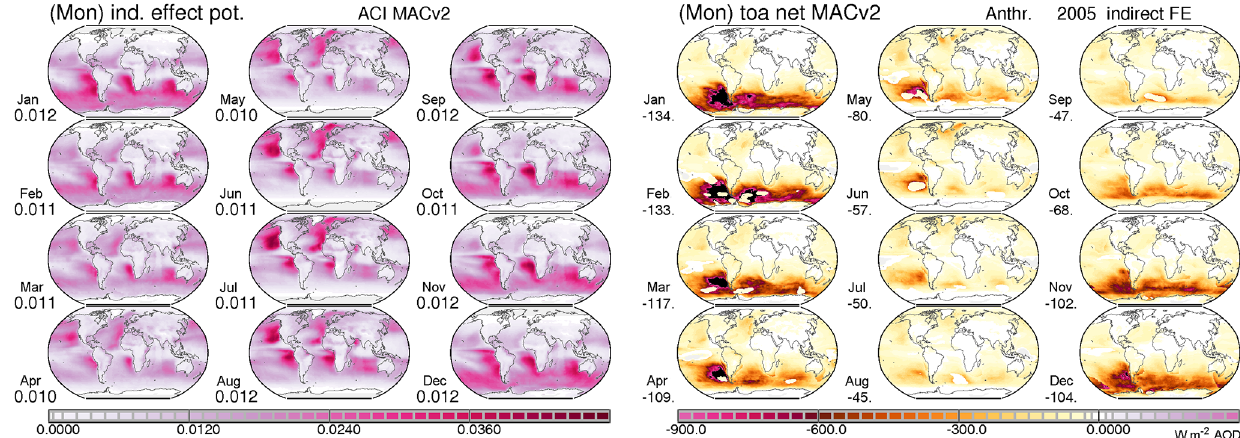
Figure F1. Monthly maps for environmental potential for aerosol indirect effects (left frame) considering low cloud cover, reflection and susceptibility, surface albedo, sunshine hours and sun elevation, and the indirect forcing efficiency (left frame).